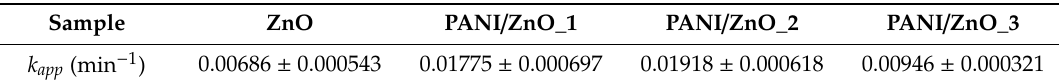
Table 4. Apparent rate constants ( k app ) of the AB 25 dye degradation extracted from ln( c o / c t ) vs. t curves given in Figure